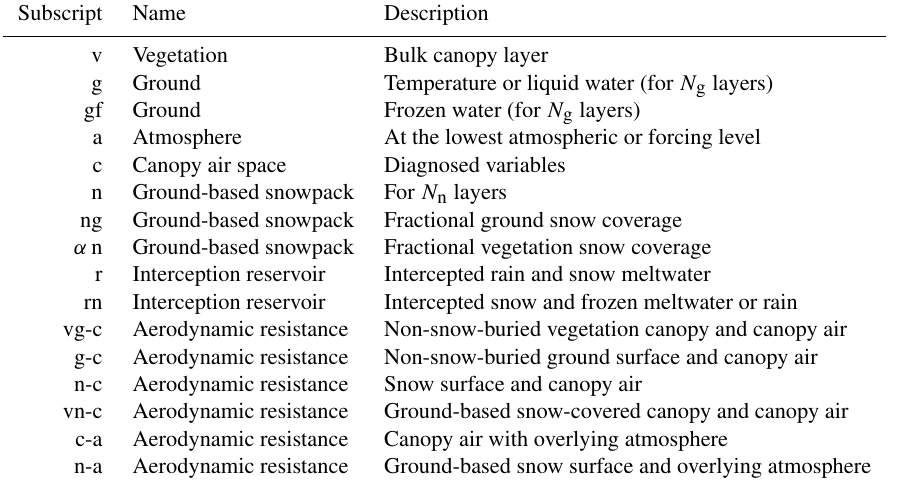
Table 2. Subscripts used to represent the prognostic and diagnostic variables. In addition, the symbols used to represent the aerodynamic resistance pathways (between the two elements separated by the dash) are also shown (refer also to Fig. 1). These symbols are used throughout the